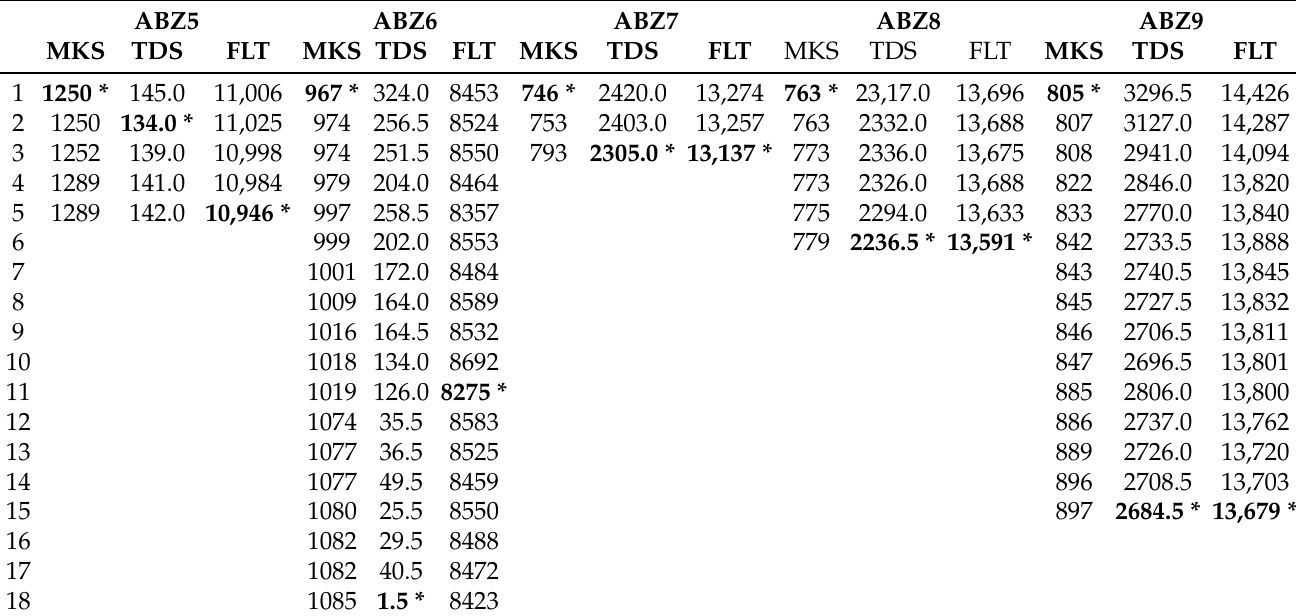
Table A4. Non-dominated front obtained by CMOSA for the JSSP instances proposed by [43].